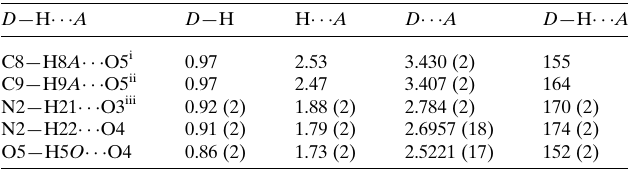
Table 1 Hydrogen-bond geometry (A˚ , (cid:4) ) for 1 .